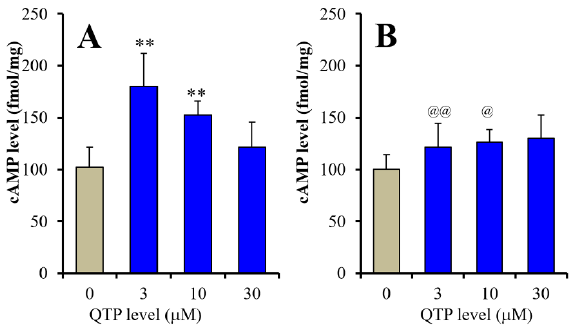
Figure 6. Concentration-dependent effects of subchronic administration of QTP ( A ) and interaction between subchronic administrations of QTP and (2R)-1-[(3-hydroxyphenyl)sulfonyl]-2-[2-(4-methyl-1-piperidinyl)ethyl]pyrrolidine hydrochloride (SB269970: 10 μM) ( B ) on intracellular cAMP level in astrocytes. Ordinates indicate mean ± SD (n = 6) of intracellular cAMP level in cultured astrocytes (f mol/mg). ** p < 0.01: relative to control (QTP free), @ p < 0.05, @@ p < 0.01: relative to SB269970 free by two-way ANOVA with Tukey’s post-hoc test.